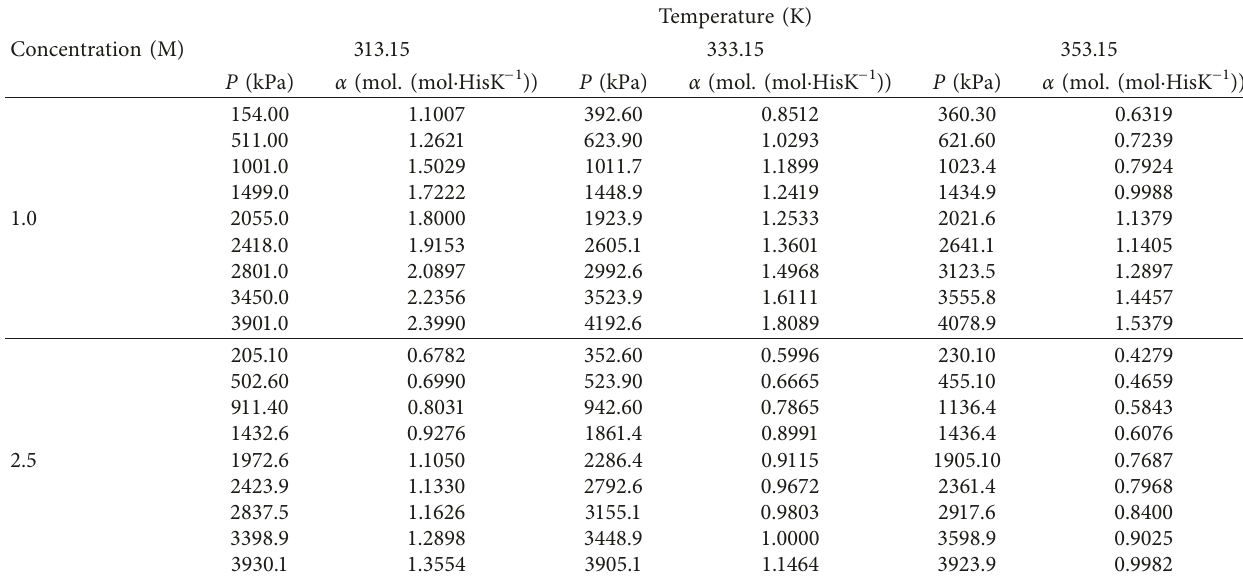
Table 6: Experimental carbon dioxide solubility in aqueous potassium salt of L